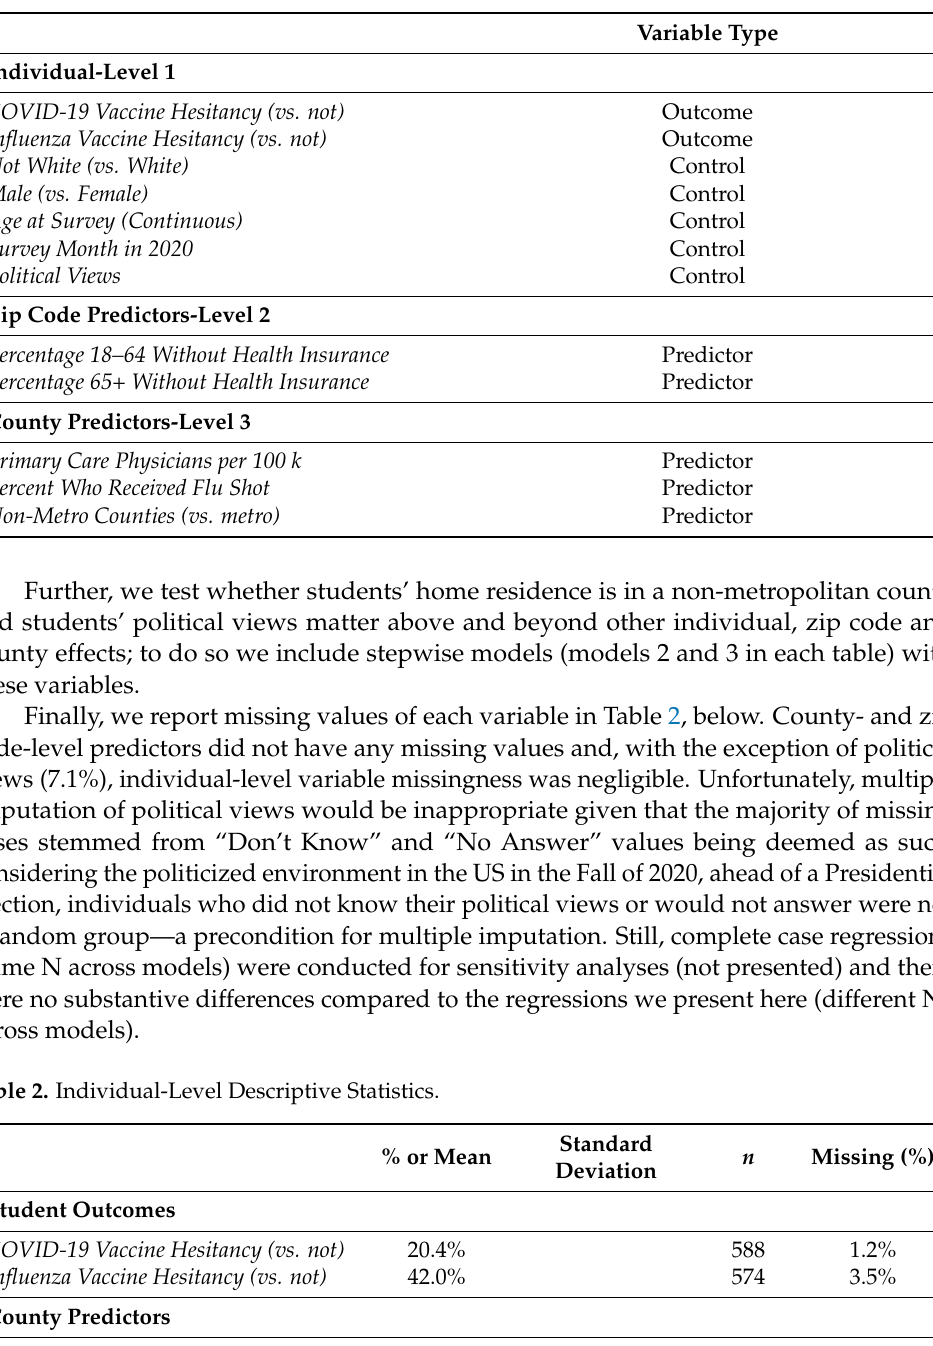
Table 1. Analytic Variables by Level and Type.